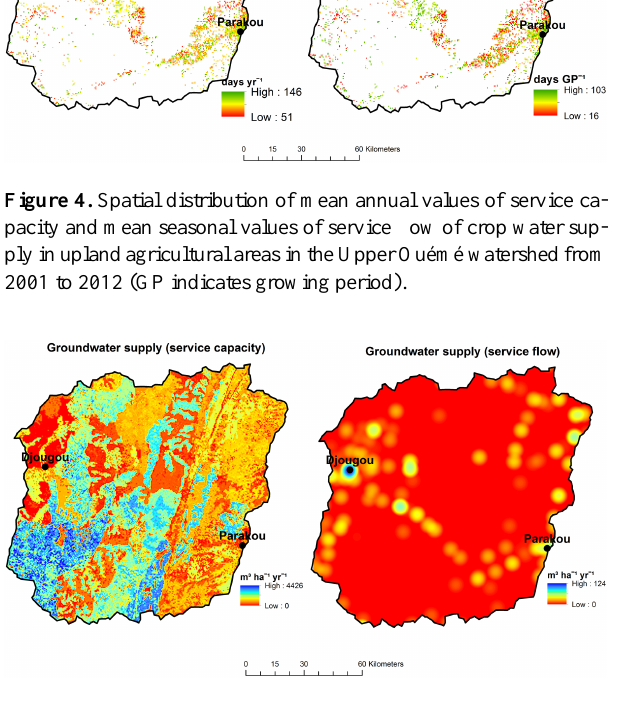
Figure 5. Spatial distribution of mean annual values of service ca- pacity and service flow of groundwater supply in the Upper Ouémé watershed from 2001 to 2012.